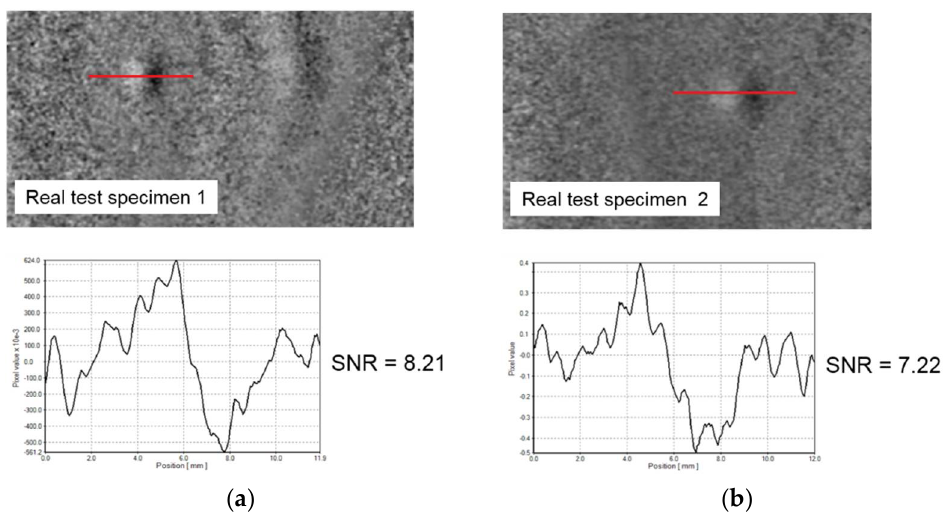
Figure 9. Shearogram, course of the intensity values along the red line and determined SNR value of ( a ) real test specimen 1, SNR ≈ 8.2; ( b ) real test specimen 2, SNR ≈ 7.2.